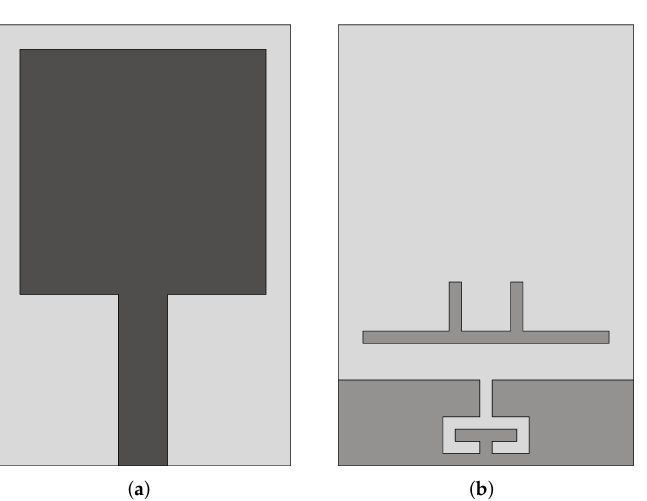
Figure 19. Geometry of the modified ground plane monopole antenna ( a ) front view and ( b ) back view (redrawn from [79]). Dark gray top metal face, medium gray bottom metal face, and light gray dielectric